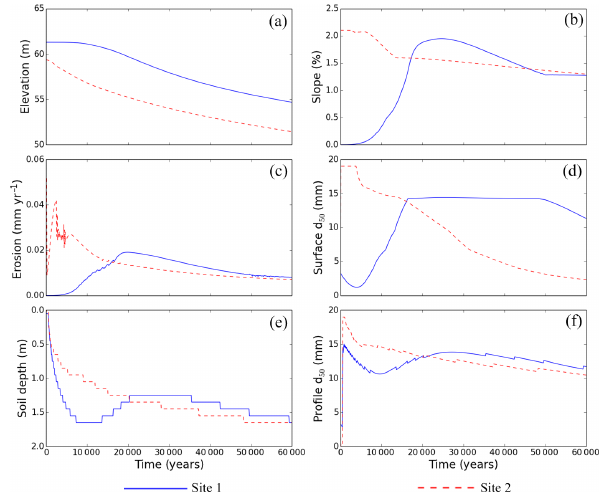
Figure 7. Evolution characteristics of sites 1 and 2: (a) elevation, (b) hillslope gradient, (c) erosion rate, (d) surface d 50 , (e) soil depth, and (f) profile d 50